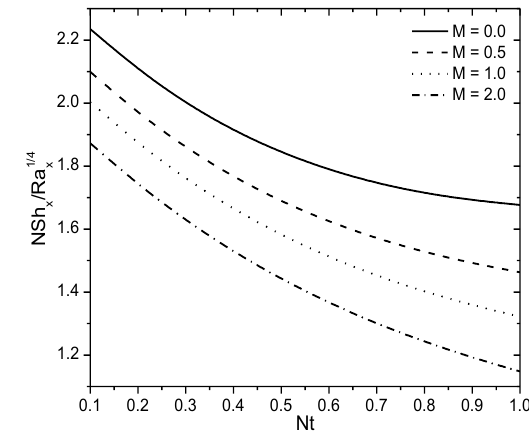
Figure 13. Effet of M on the Local Nusselt number Figure 14. Effet of M on the Local nanoparticle